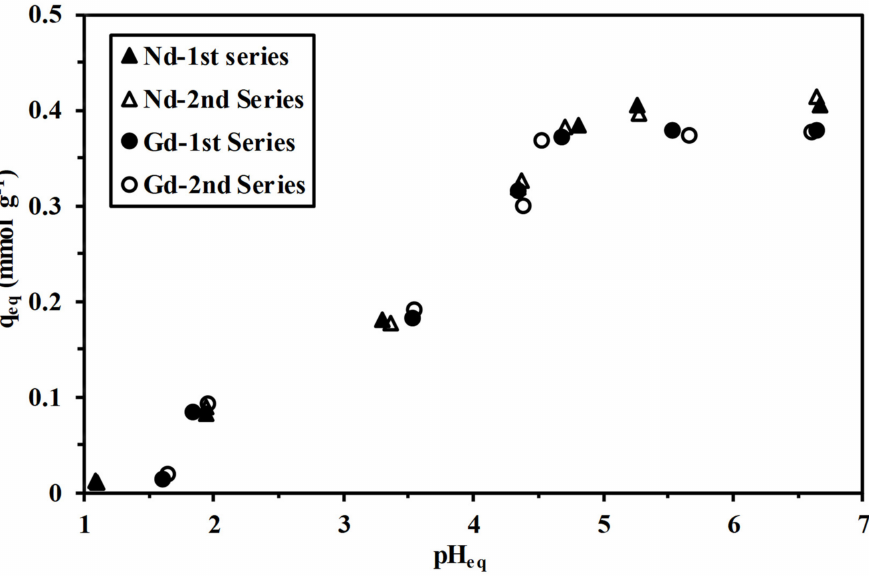
Figure 4. Effect of equilibrium pH on Nd(III) and Gd(III) sorption capacities using mesoporous composite functionalized sorbent (C 0 : 0.63–0.66 mmol metal L − 1 ; sorbent dosage (SD): 1.42 g L − 1 ; contact time: 48 h; agitation speed: 170 rpm; T: 22 ± 2 ◦